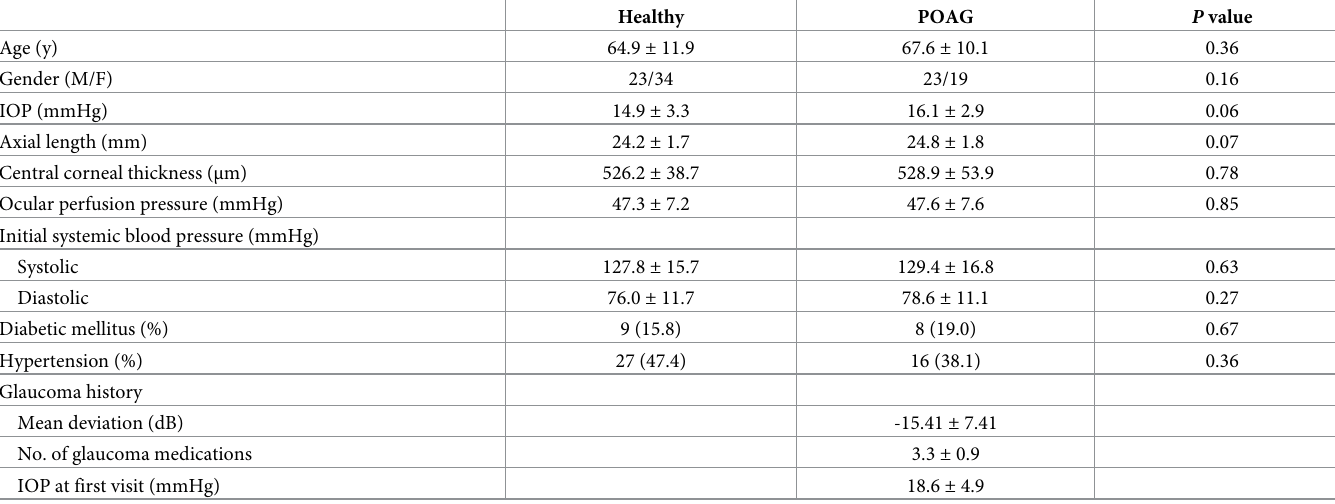
Table 1. Clinical characteristics of healthy controls and primary open-angle glaucoma patients.